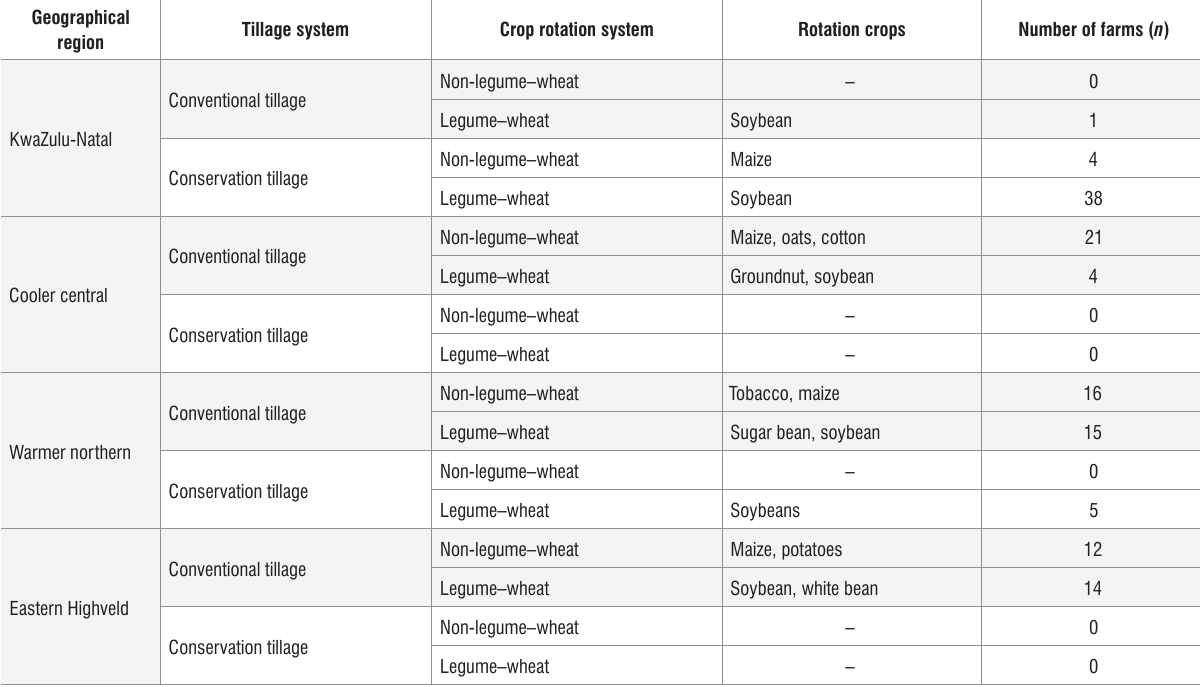
Table 2: Tillage and crop rotation practices of South African wheat producers who participated in the study Geographical Tillage system Crop rotation system Rotation crops Number of farms ( n ) region Conventional tillage KwaZulu-Natal